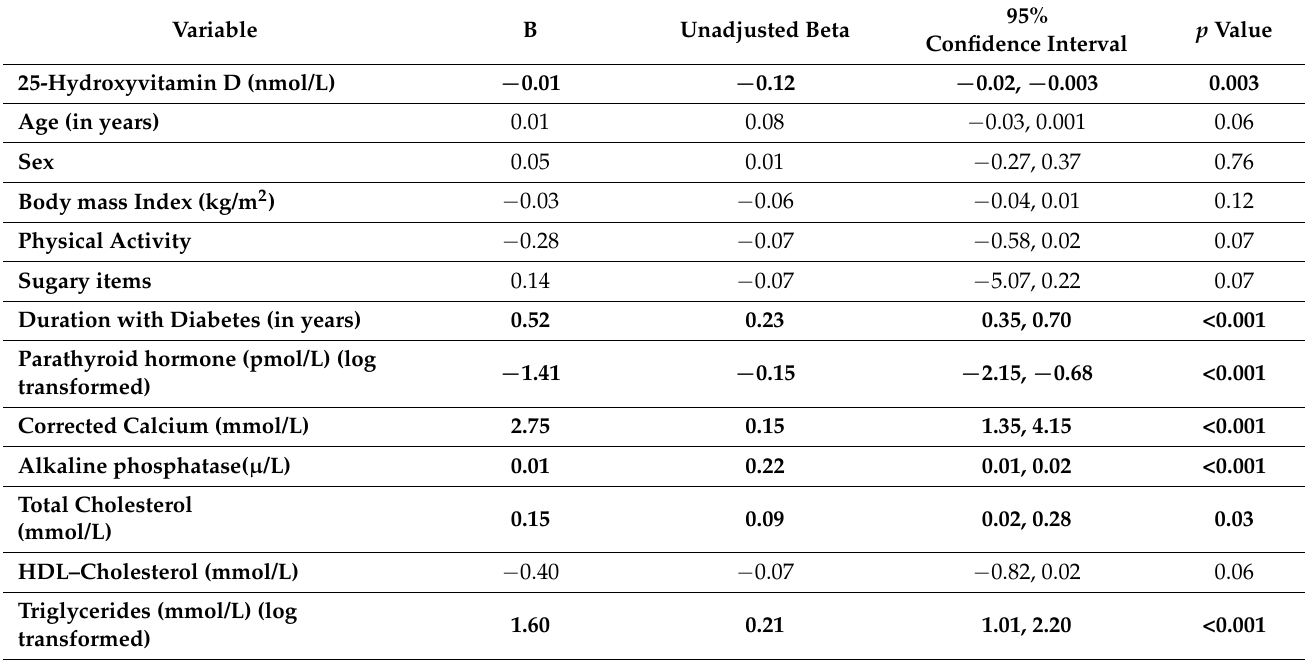
Table 2. Univariable linear regression analysis showing unadjusted beta and 95% confidence interval (CI) for variables associated with HbA1c in Saudi patients with diabetes in Riyadh, Saudi Arabia. Variable B Unadjusted Beta